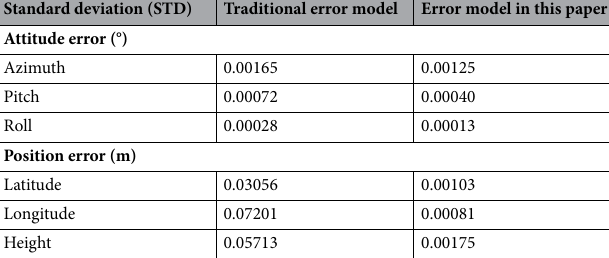
Table 2. The relative navigation errors for the imaging segment